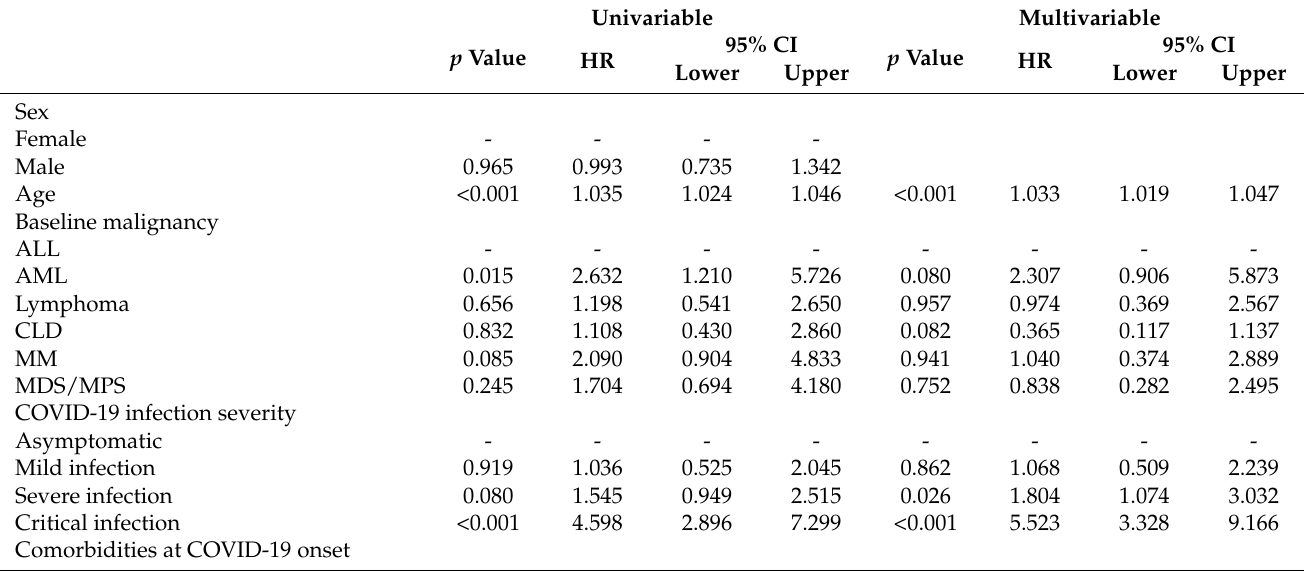
Table 3. Univariable and multivariable analysis for risk factors for mortality (whole cohort).